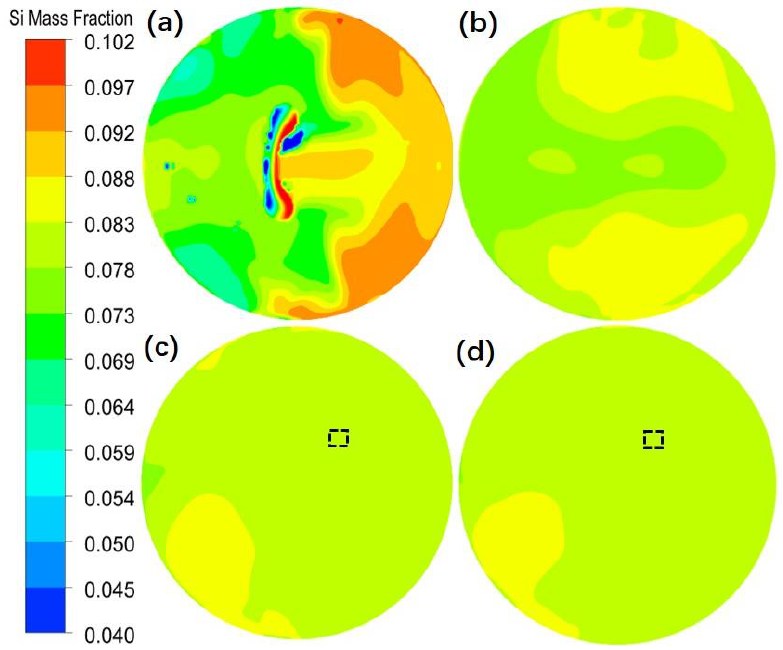
Figure 4. Concentration fields along the cross-section at half of the height of the mixture when stood for ( a ) 0 s, ( b ) 0.5 s, ( c ) 1.0 s and ( d ) 1.2 s.